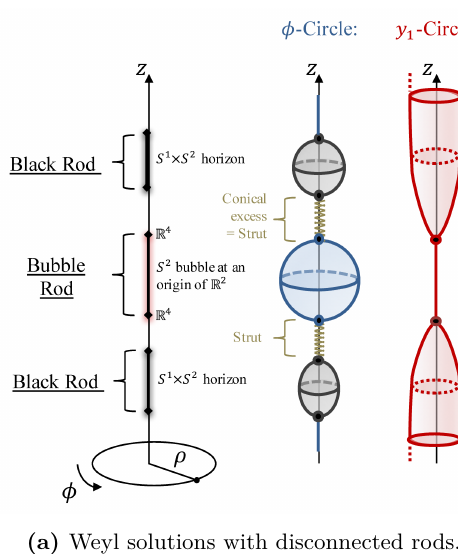
Figure 2. Schematic description of static axisymmetric Weyl solutions in five dimensions and the behavior of the φ and y circles on the z -axis. Solutions can be sourced by black rods or bubble 1 rods (topological stars) that can be wrapped by electromagnetic fluxes. At each rod, the φ circle has a finite size on the z -axis. The multiple objects are separated by struts (a) except if two rods of different nature are connected